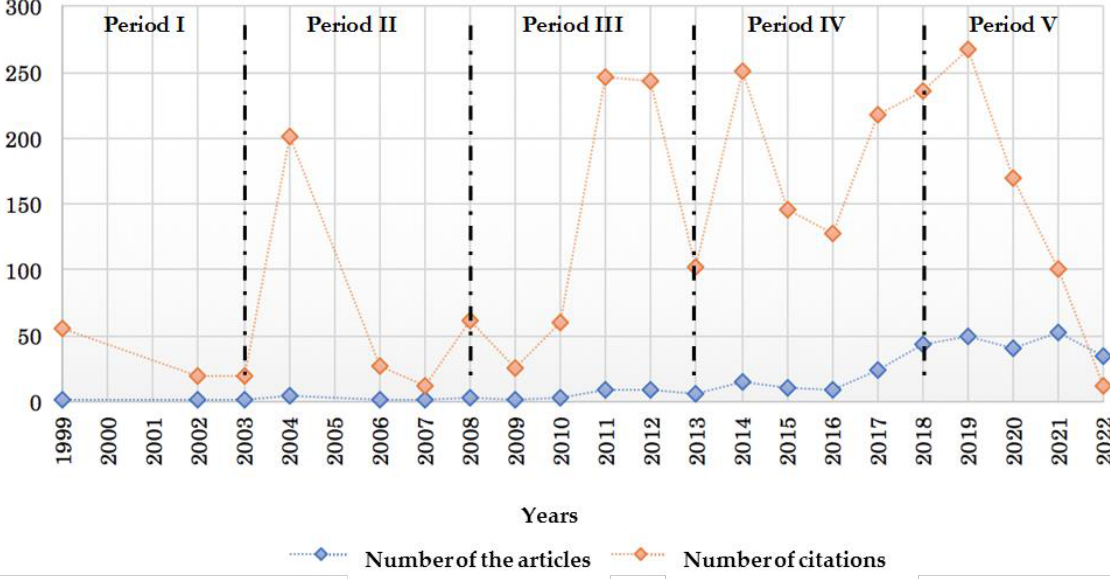
Figure 2. The number of publications and citations per year. Note: Please remember that the information for the year 2022 represents half of the year since the date of consultation and downloading of the information was in July of that year.